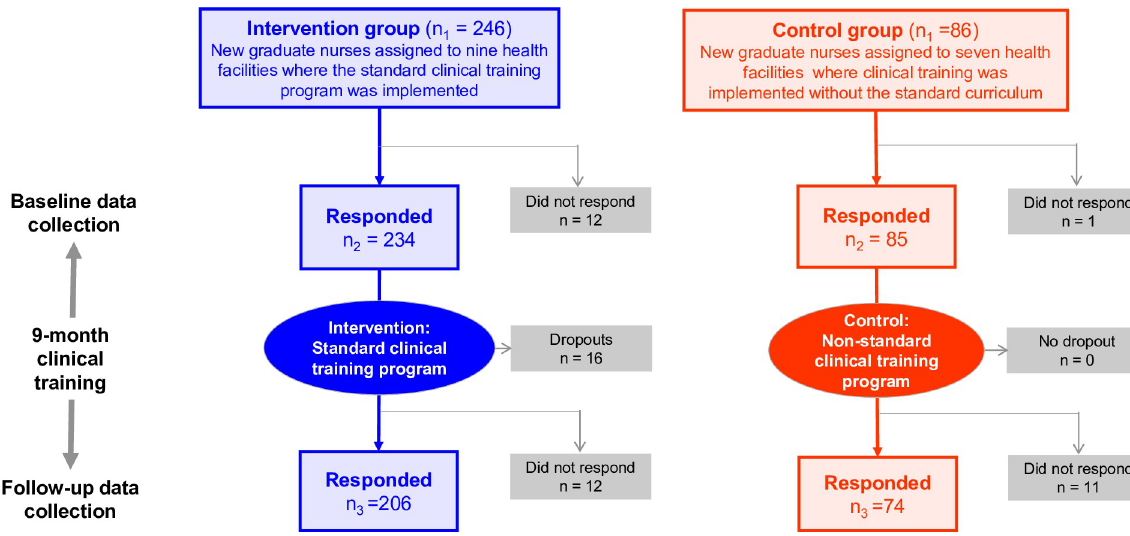
Fig 1. Flow diagram showing the number of study participants in the intervention and control